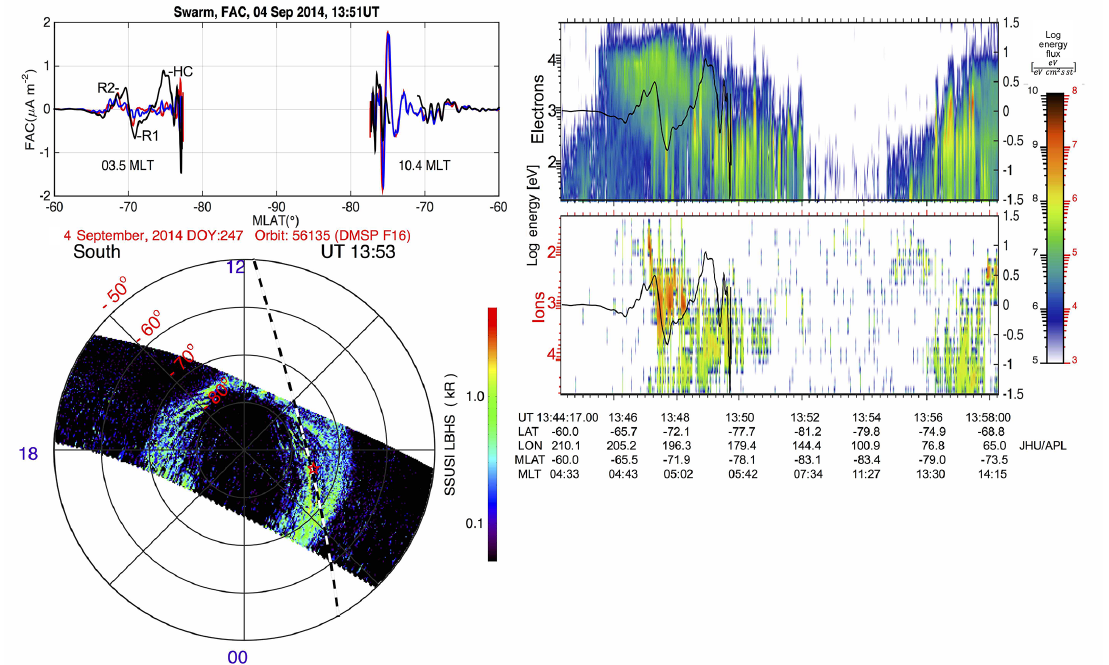
Figure 5. Composite plot of Swarm and DMSP observations of a polar cap event in the Southern Hemisphere. Presented are field-aligned currents along the Swarm track (top left), where the black curve shows dual-SC FAC and the red and blue curves show results from Swarm A and C, respectively. Auroral images and the Swarm orbit track are illustrated below. Precipitating particle spectrograms with FAC profiles over-plotted are shown to the right, with electrons at the top and ions at the bottom.